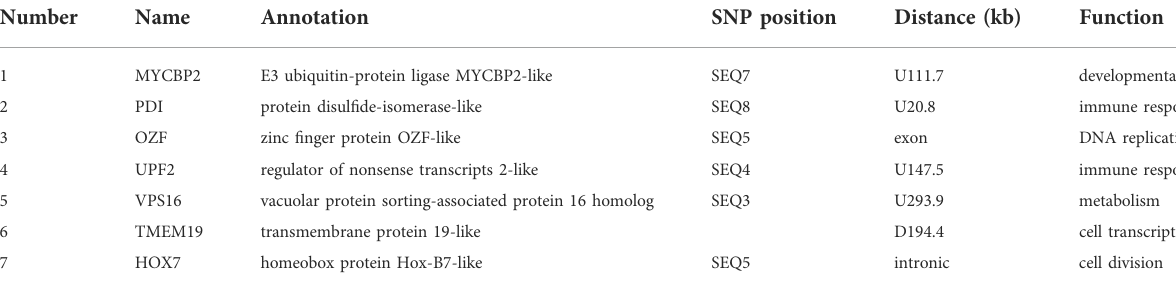
TABLE 3 Candidate genes found by GWAS of ammonia nitrogen tolerance.